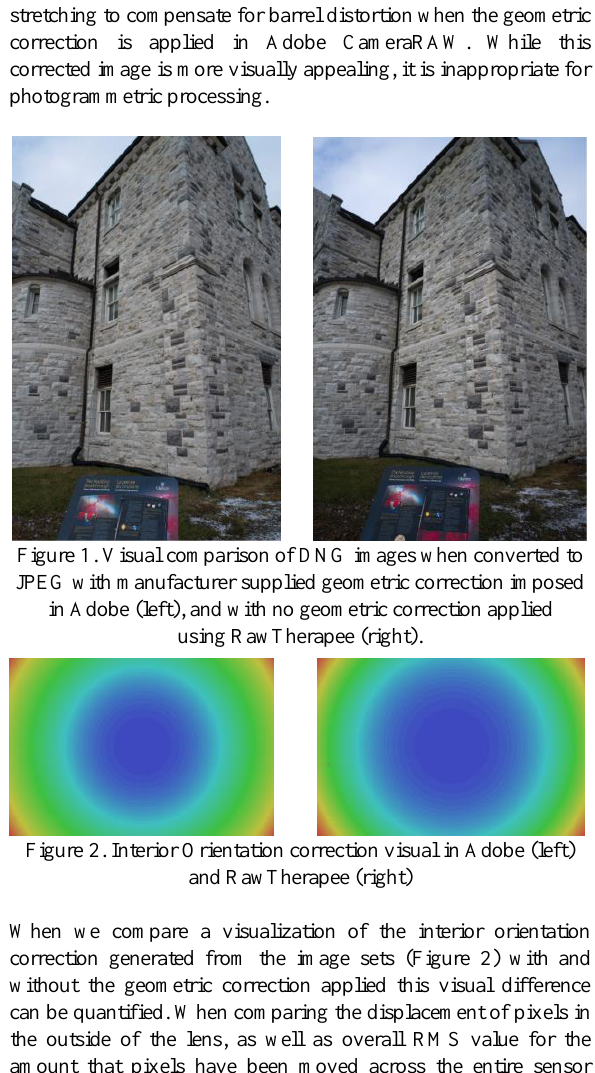
amount that pixels have been moved across the entire sensor (Table 3), the effects the manufacturer’s software-based lens correction has on the calibration parameters becomes